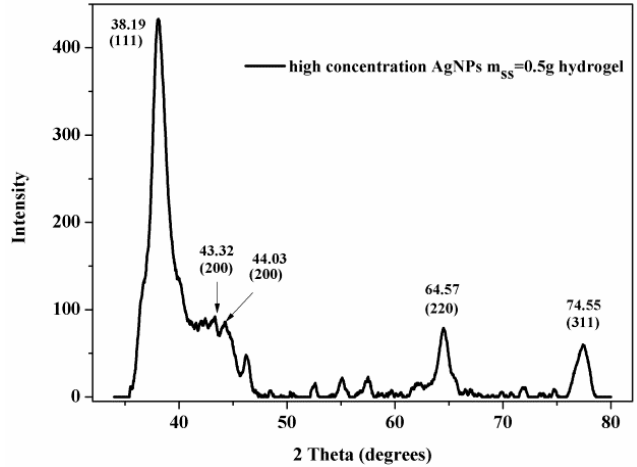
Figure 4. XRD of m ss = 0.5 g hydrogel.